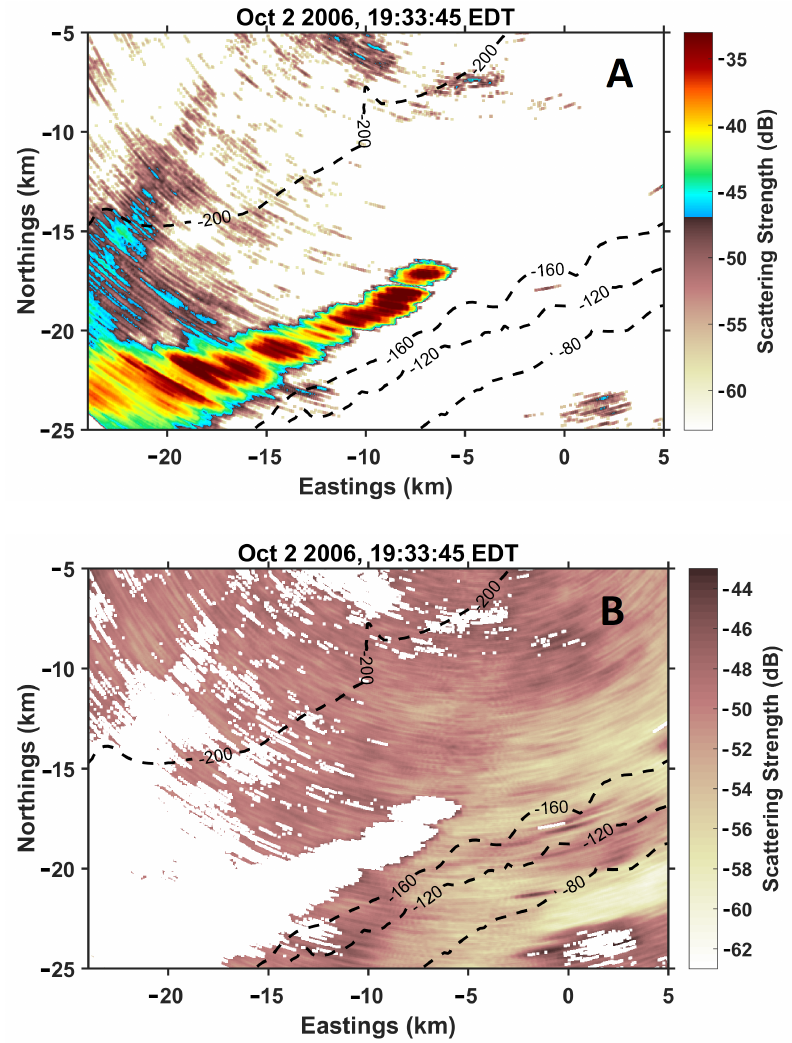
Figure 9. Same as Figure 8 except OAWRS scattering strength is measured on 2 October 19:33:45 EDT. Each pixel in Figure 5B is classified as being dominated by fish or seafloor scattering using relative frequency responses obtained by subtracting the mean instantaneous average scattering strength across frequency at each pixel. ( A ) Pixels classified as dominated by fish scattering. ( B ) Pixels classified as dominated by seafloor